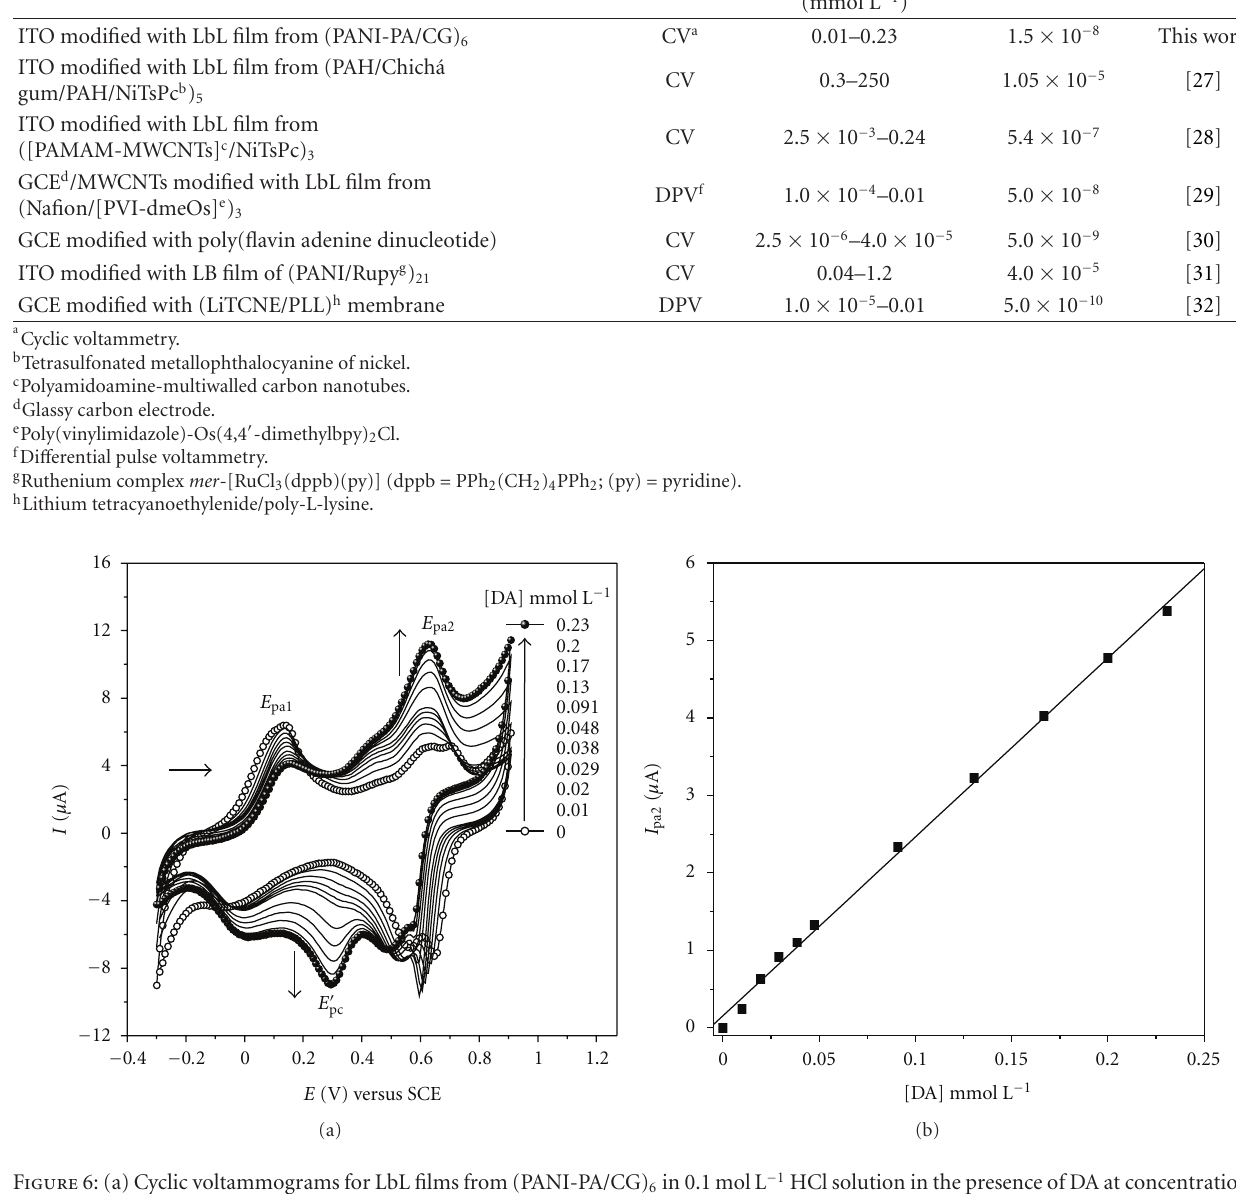
Figure 6: (a) Cyclic voltammograms for LbL films from (PANI-PA/CG) 6 in 0.1molL − 1 HCl solution in the presence of DA at concentrations ranging from 0.01 mmol L − 1 to 0.23 mmol L − 1 (from bottom to top). (b) The dependence of peak current ( I ap2 ) on the DA concentration. Scan rate: 50 mVs − 1